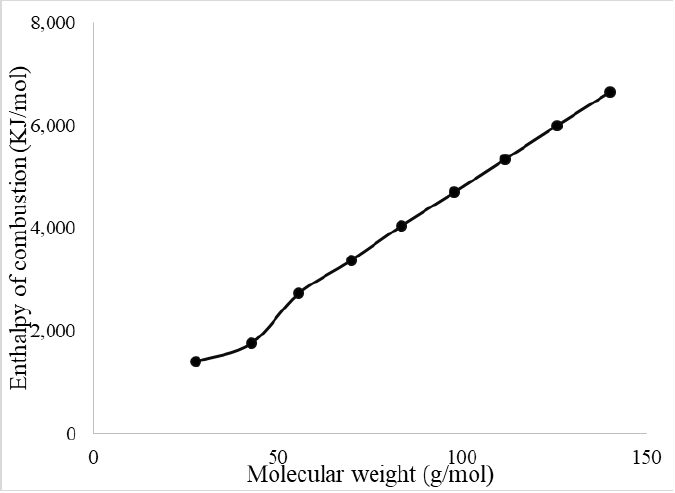
Figure 13. The effect of molecular weight of olefins on enthalpy of combustion .